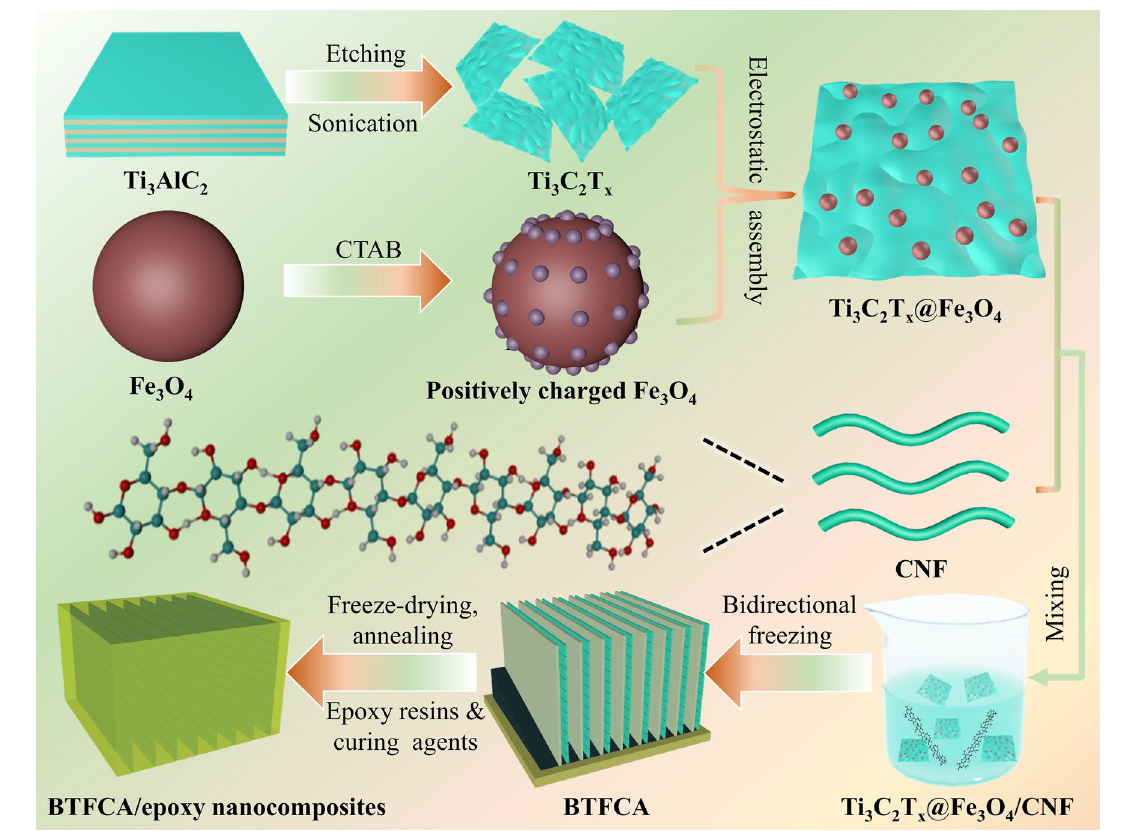
Fig. 1 Schematic illustration of fabrication process for BTFCA/epoxy